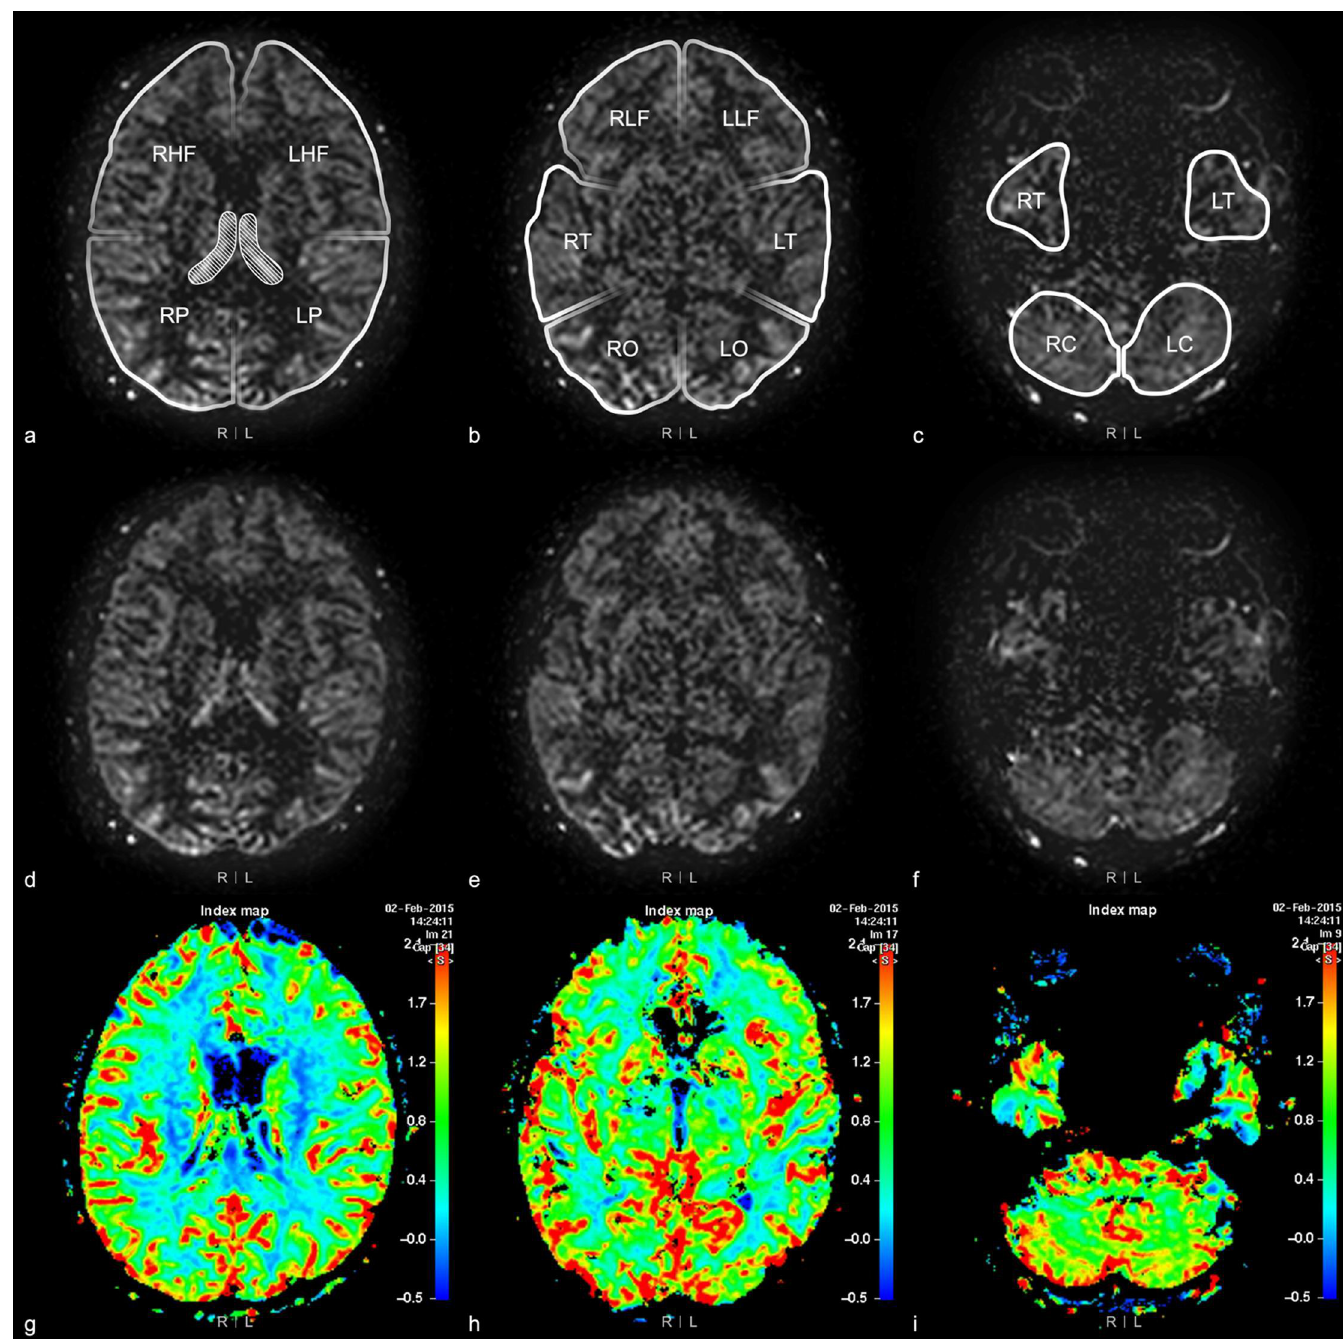
Fig 2. 12 areas of bilateral cerebral and cerebellar hemispheres. Brain MRI of a 76-year-old woman with dizziness. 12 areas on arterial spin labeling images are shown in figures (a), (b), and (c). Figures (d), (e), and (f) are ASL images and figures (g), (h), and (i) are cerebral blood flow map. Figures (a), (d), and (g) show the most superior portion of the bilateral choroid plexus (regions marked by oblique lines in figure (a)). The image slices above the landmark, the choroid plexus in the trigone, are divided into right and left high frontal (RHF, LHF) and parietal (RP, LP) areas, and the lower image slices are divided into the other eight areas; the low frontal (RLF, LLF), temporal (RT, LT), occipital (RO, LO), and cerebellar (RC, LC) areas on both sides.